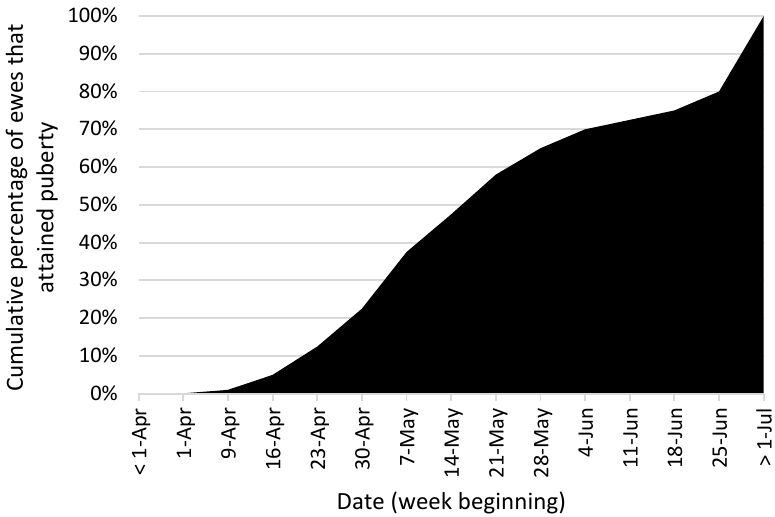
Figure 1. The cumulative proportion of ewes that attained puberty each week of the breeding period in the South Island of New Zealand (adapted from [11]). Note: In New Zealand, mature breeding begins in March/April, and the shortest day occurs on 21 June.